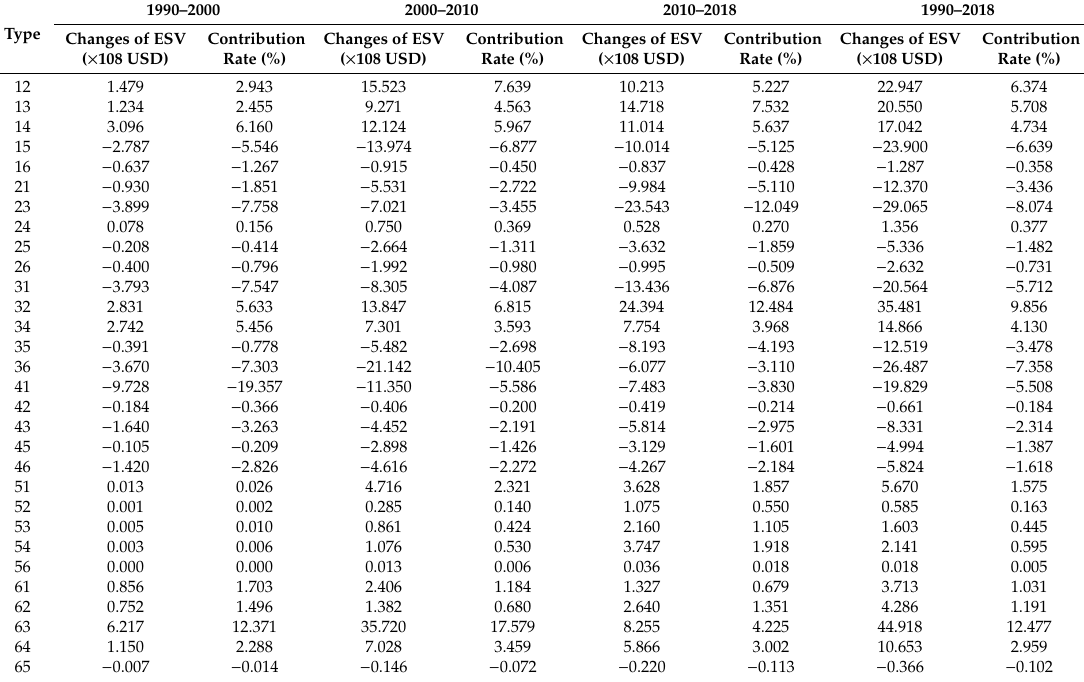
Table 5. Changes in the total ESV in response to LUT in the YRB from 1990 to